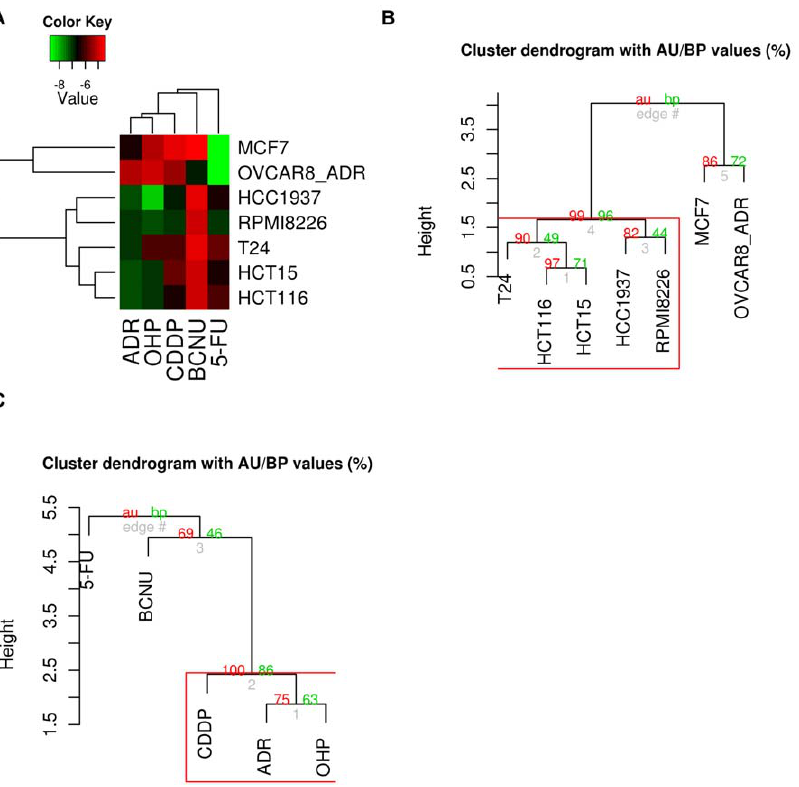
Figure 1. Hierarchical clustering of the cell lines and of the drugs. Based on the log10(IC20), the clustering used the Euclidean dissimilarity measure. A. Heat map representation of the clusters. Brightness of the colour is correlated with log10(IC20), with red colour for higher IC20 and green for lower IC20. B. Cell lines dendrogram with clusters significance values. C . Treatments dendrogram with clusters significance values. P -values (AU (Approximately Unbiased) in red and BP P values (Bootstrap Probability) in green are reported on the dendrograms.